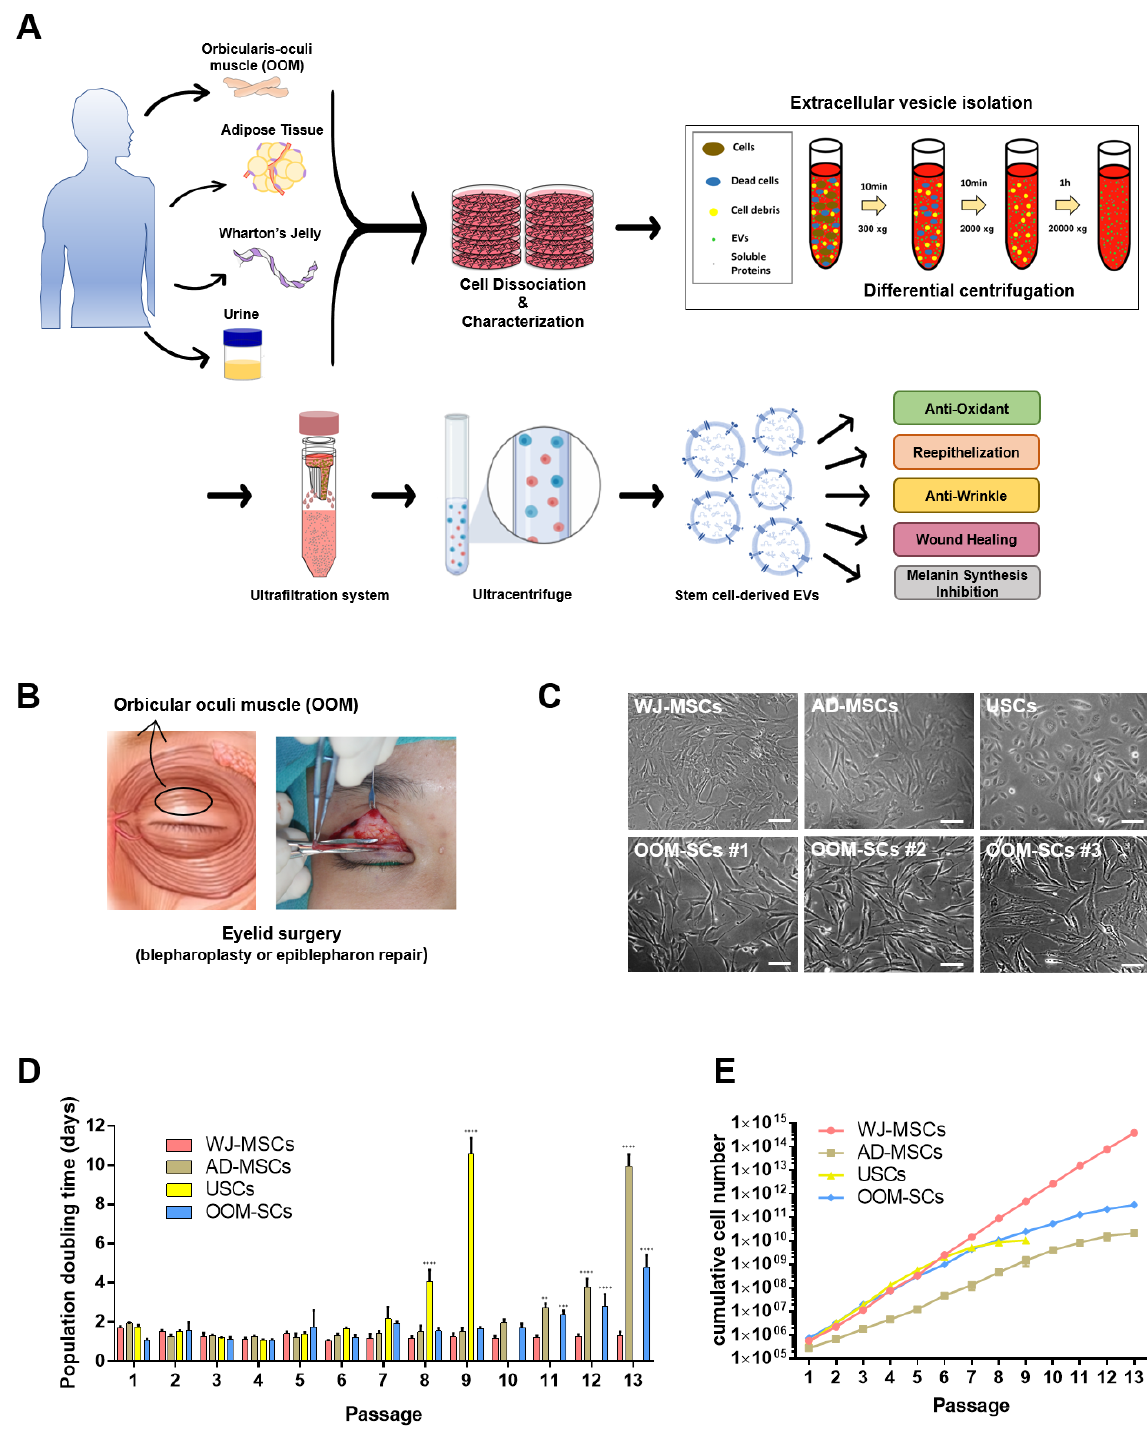
Figure 1. Schematic representation for application of novel OOM-SC-EVs and OOM-SCs preparation. ( A ) Schematic representation of isolation of stem cells from various sources, such as OOM, adipose tissue, Wharton’s Jelly, and urine and then their characterization, which were carried out via the enzymatic digestion using collagenase type II. USCs were obtained via centrifugation at 400× g , and purification of EVs from OOM-SCs and WJ-MSCs using differential centrifugation, ultrafiltration, and ultracentrifugation. Our study sought the therapeutic applications of the purified EVs including antioxidant, anti-senescence, whitening, and wound healing. OOM-SC-EVs were isolated from the collected culture soup of the OOM-SCs cultured in α -MEM medium containing exosome-depleted 10% FBS for two days, which